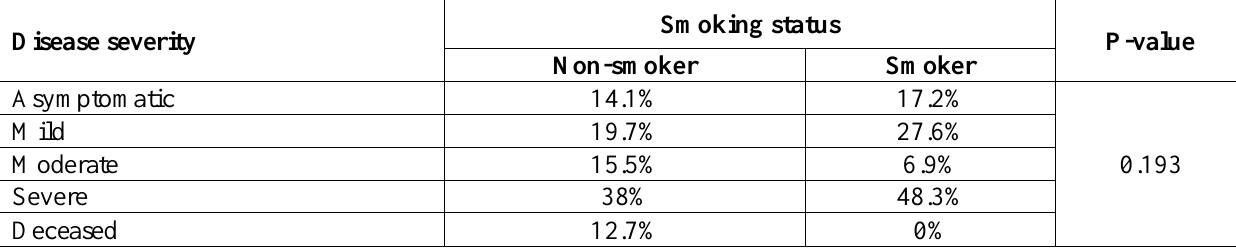
Table 2: Distribution of smokers in 100 patients with